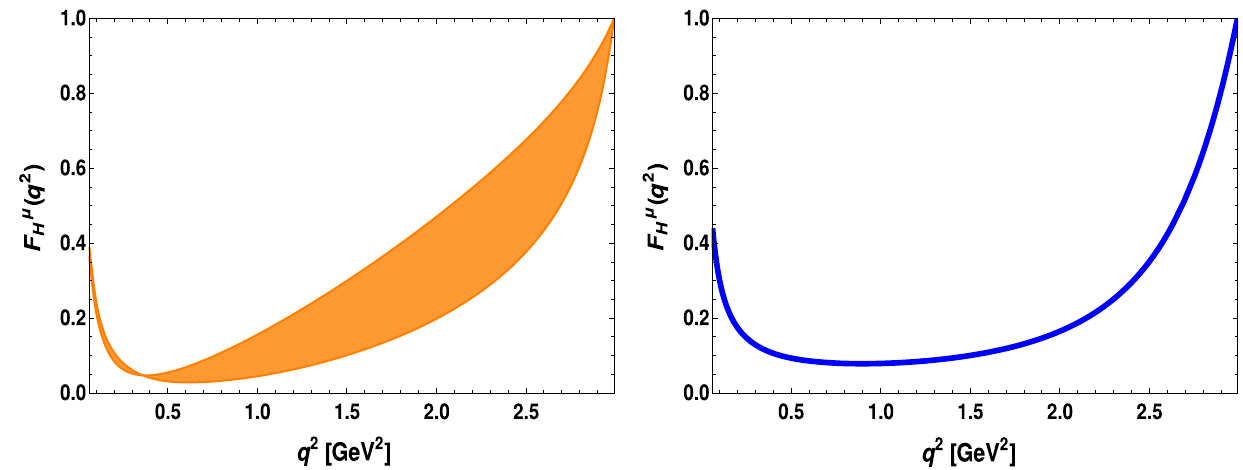
Fig. 8 The variation of flat term of the LFV process D + → π + μ − e + in the leptoquark model ( left panel ) and generic Z (cid:2) model ( right panel ) with respect to q